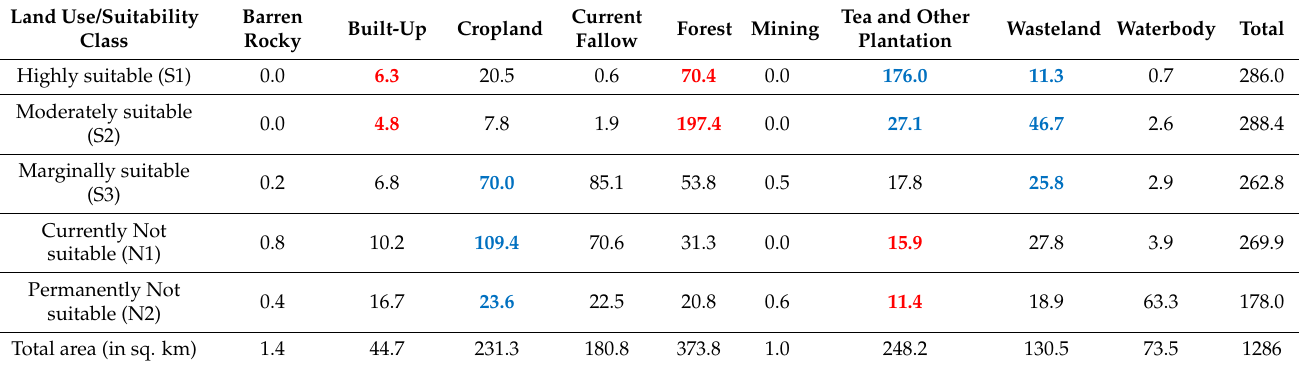
Table 10. Area comparison between land suitability classes (tea) and land use in 2015.